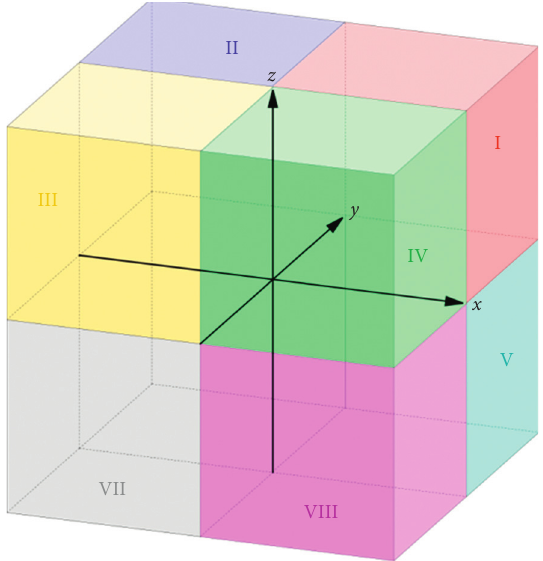
Figure 6: Preparatory division of underwater acoustic target’s location areas.